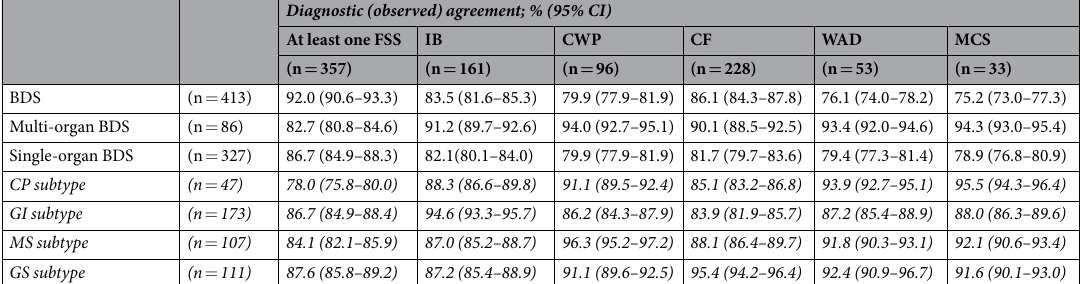
Table 3. Diagnostic agreement between functional somatic syndromes and bodily distress syndrome. Abbreviations: FSS = functional somatic syndrome; IB = irritable bowel; CWP = chronic widespread pain; CF = chronic fatigue; WAD = whiplash associated disorders; MCS = multiple chemical sensitivity; BDS = bodily distress syndrome; CP = cardiopulmonary; GI = gastrointestinal; MS = musculoskeletal; GS = general symptoms type; CI = confidence